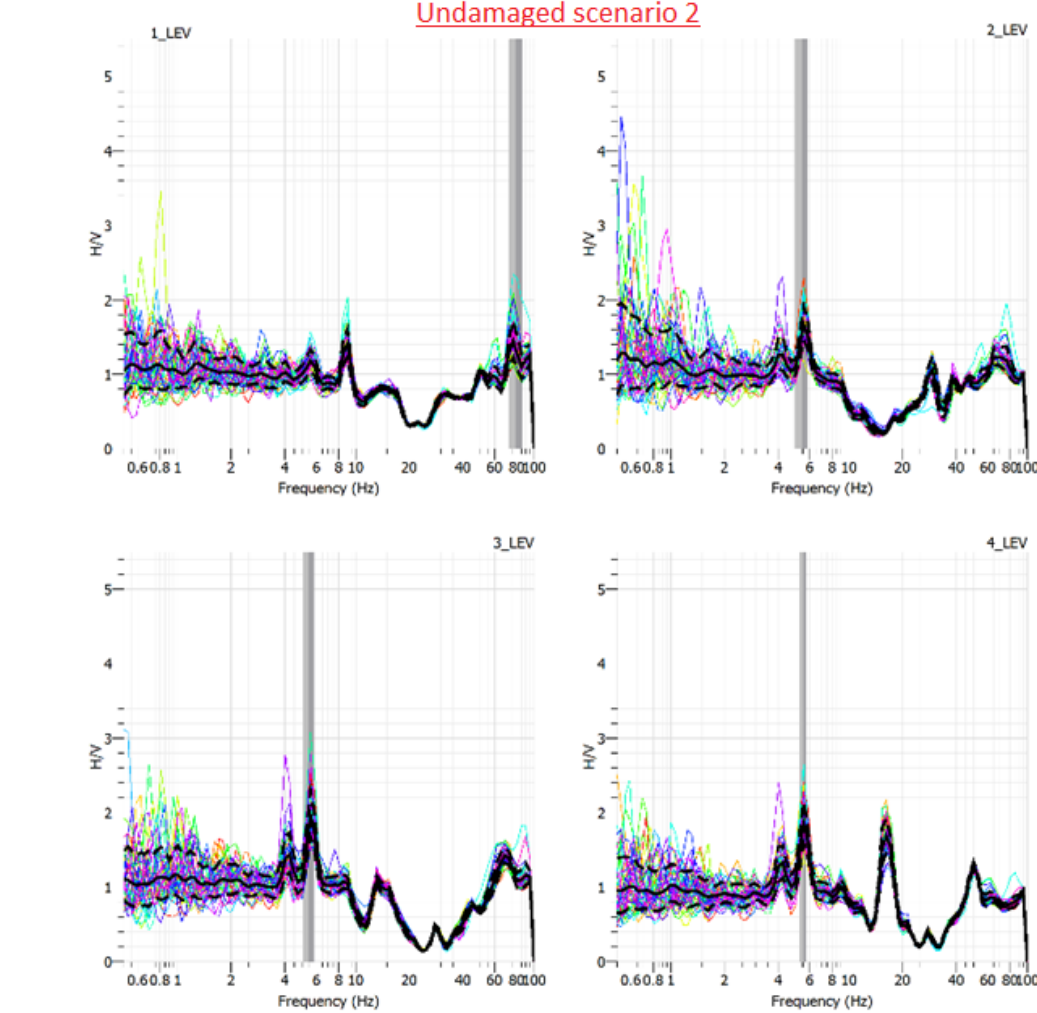
Figure 27. HVSR analysis of ambient noise recording, for undamaged scenario 2 of the metallic model.